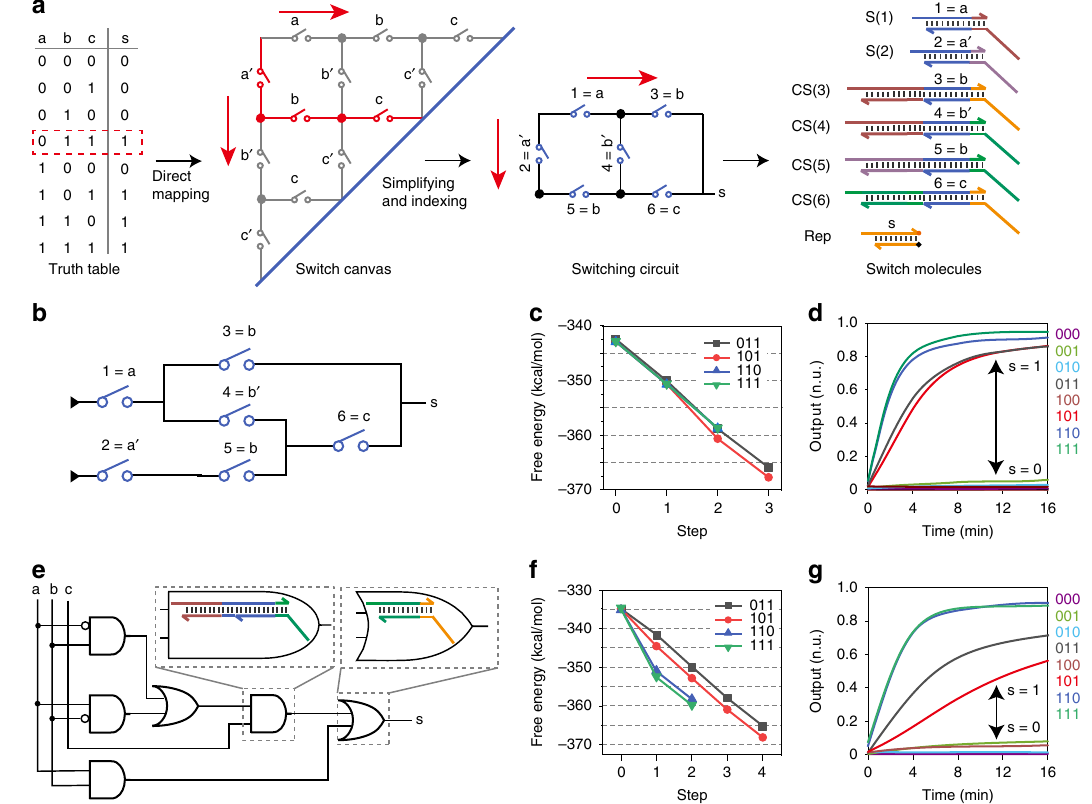
Fig. 4 Implementing arbitrary Boolean functions with DSCs. a The mapping process from a logic function to a DSC for a three-input voting logic. b DSC for the voting logic in a . c Change in free energy of stepwise switch fl ipping with each input combination that leads to output. d Experimental fl uorescence readout with DSC. e Logic circuit implementation of the voting logic in a . f Change in free energy of stepwise gate opening with each input combination that leads to output. g Experimental fl uorescence readout with logic gate implementation. Source data are provided as a Source Data fi